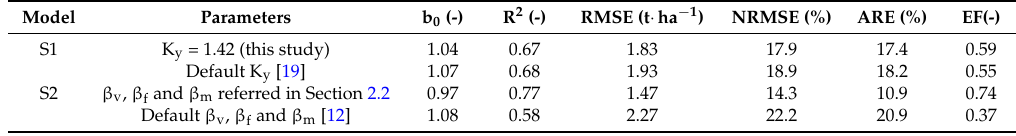
Table 9. Indicators of “goodness of fit” relative to estimating maize yield using the S1 and S2 models. Model Parameters b 0